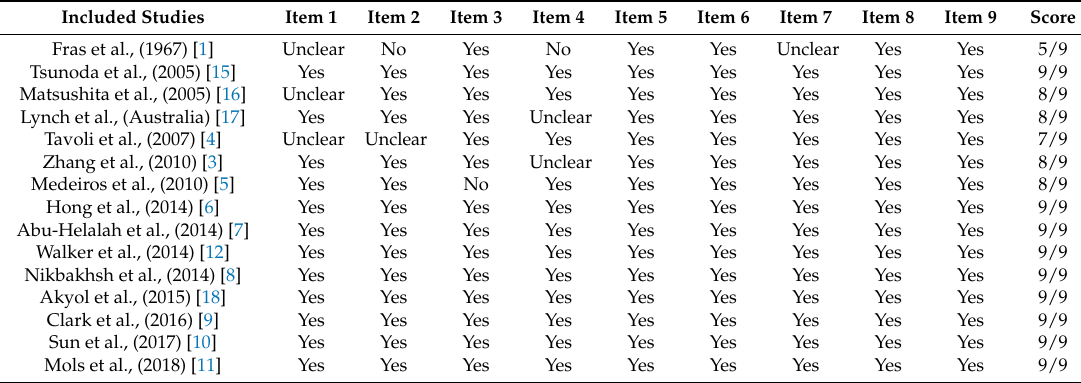
Table 3. Quality assessment of the included trials following the JBI (Joanna Briggs Institute) Critical Appraisal